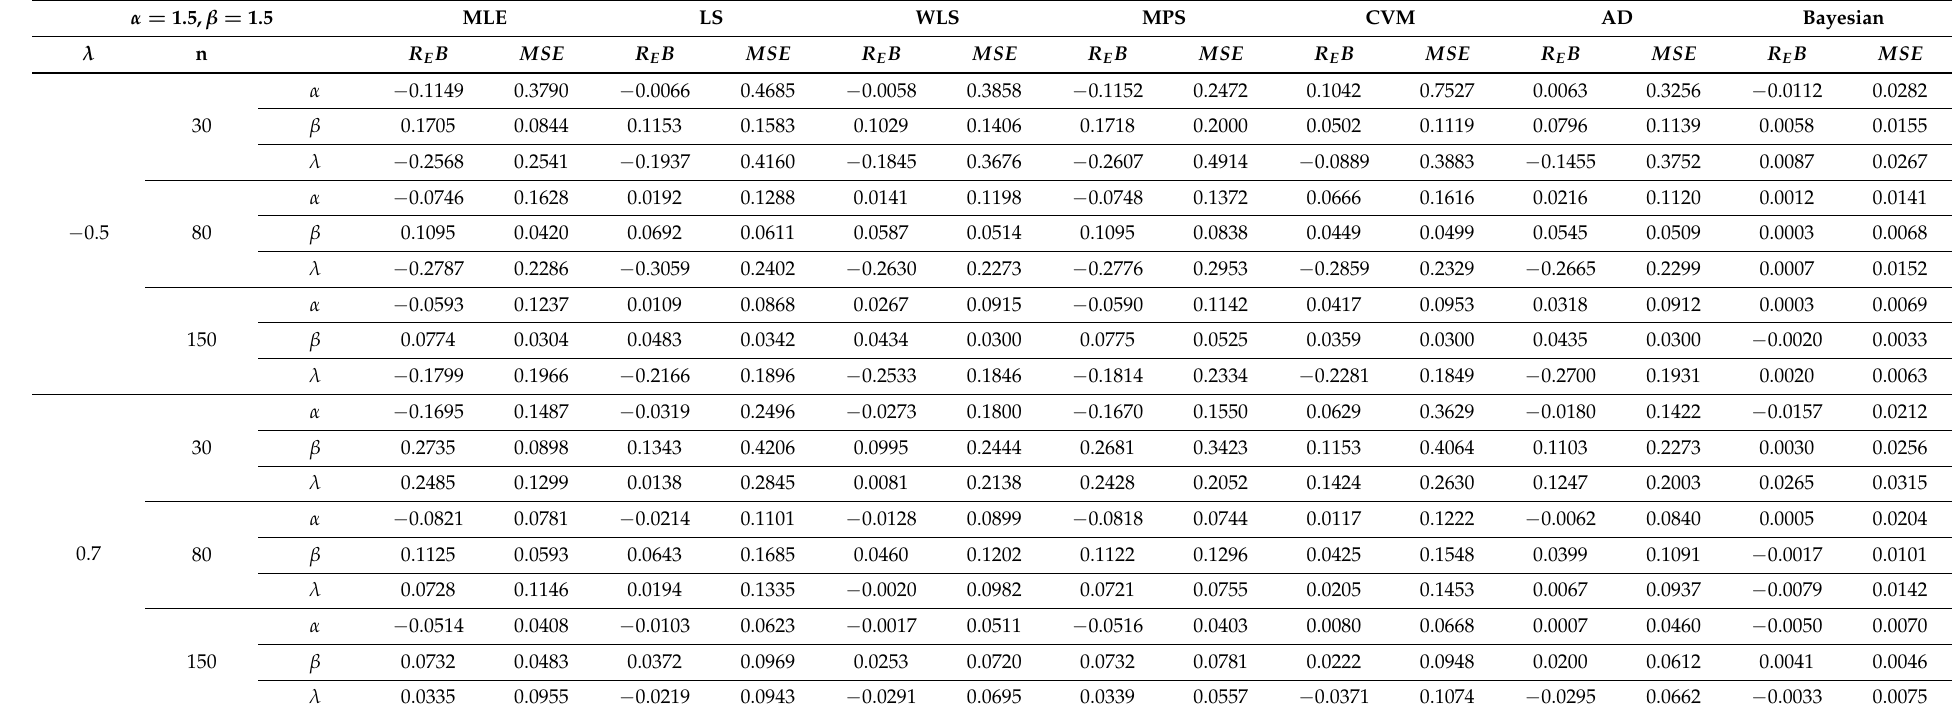
Table 1. Numerical outcomes of R E B and MSE for all estimation approaches at Case